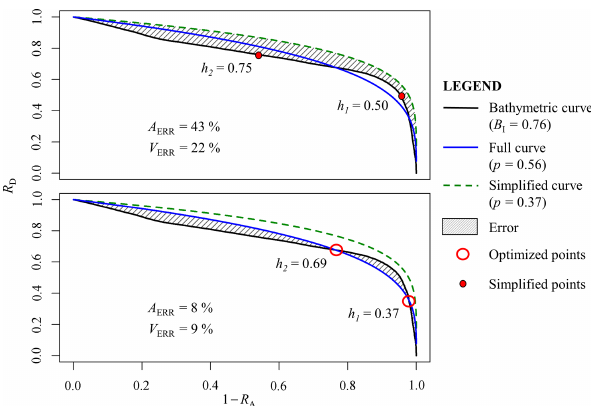
Figure 8. Comparison of the bathymetric curve for Pond 7 with the full and simplified curve. The top shows the area ( A ERR ) and volume ( V ERR ) error associated with the simplified curve that was calculated using simplified depths h 1 and h 2 and the bottom shows the error associated with the full curve and the optimum location for depths h 1 and h 2 . R D is relative depth, R A is relative area, B I is the bathymetric integral, and p is the morphometry